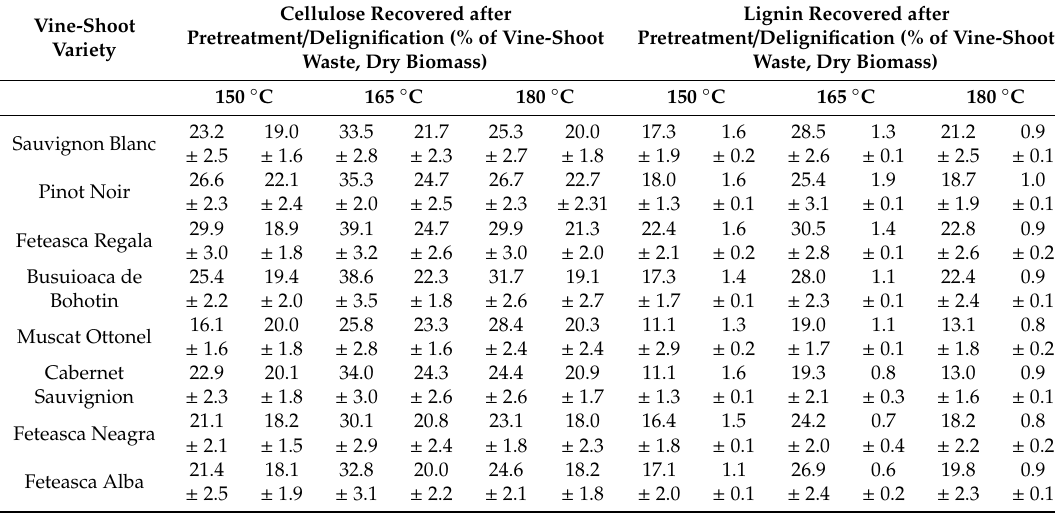
Table 2. Mass balance for cellulose and lignin recovered in residual